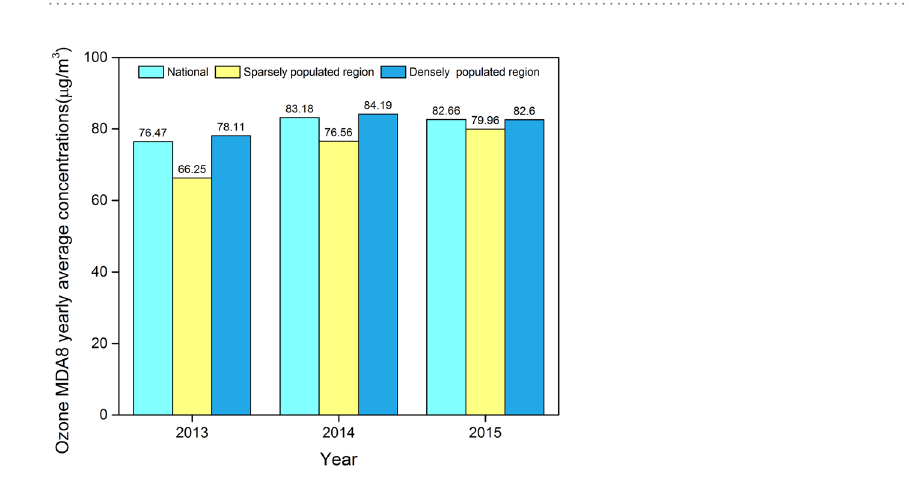
Figure 4. The maximum daily eight-hour average (MDA8) concentrations of annual averaged ground-level ozone in